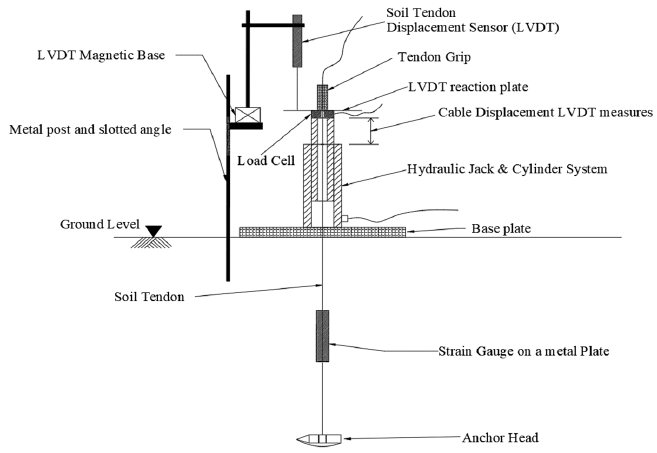
Figure 10. Schematics of field anchor pull-out test.